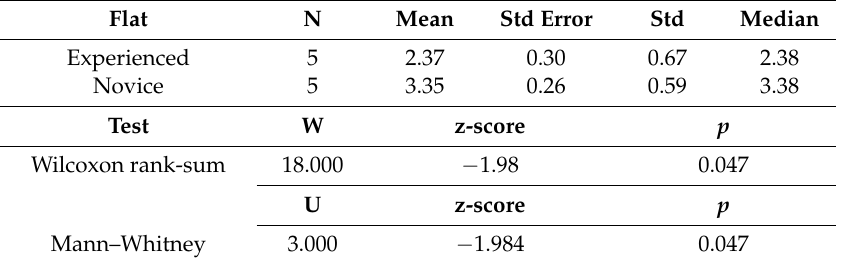
Table 16. Test for correlation between user skills level and task duration in flat